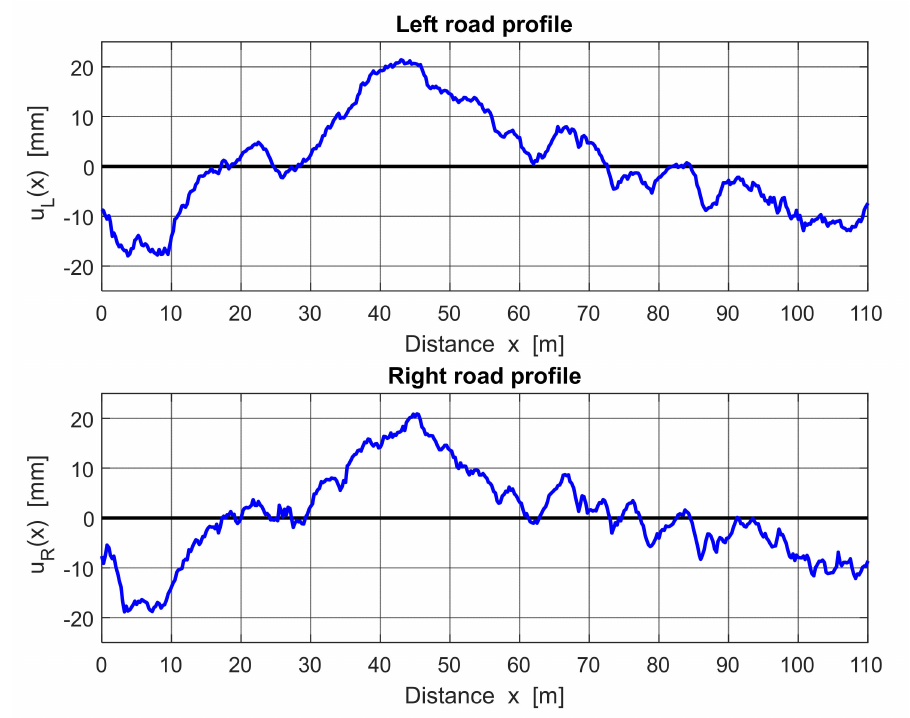
Figure 2. Left and right road